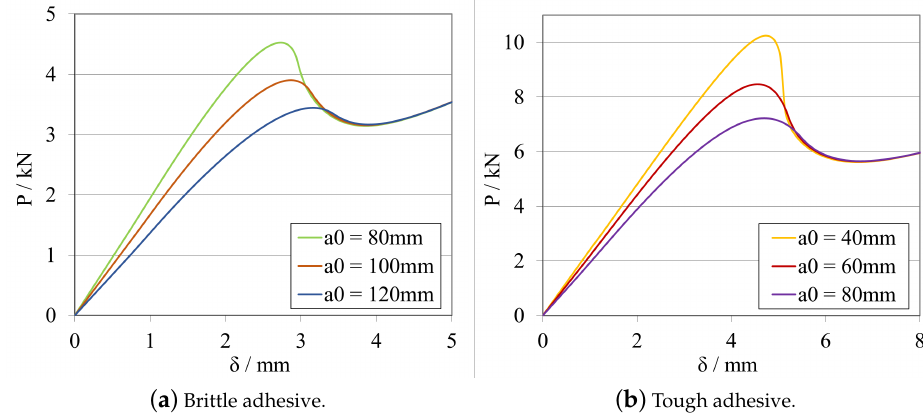
Figure 8. P - δ curves related to the a 0 ELS